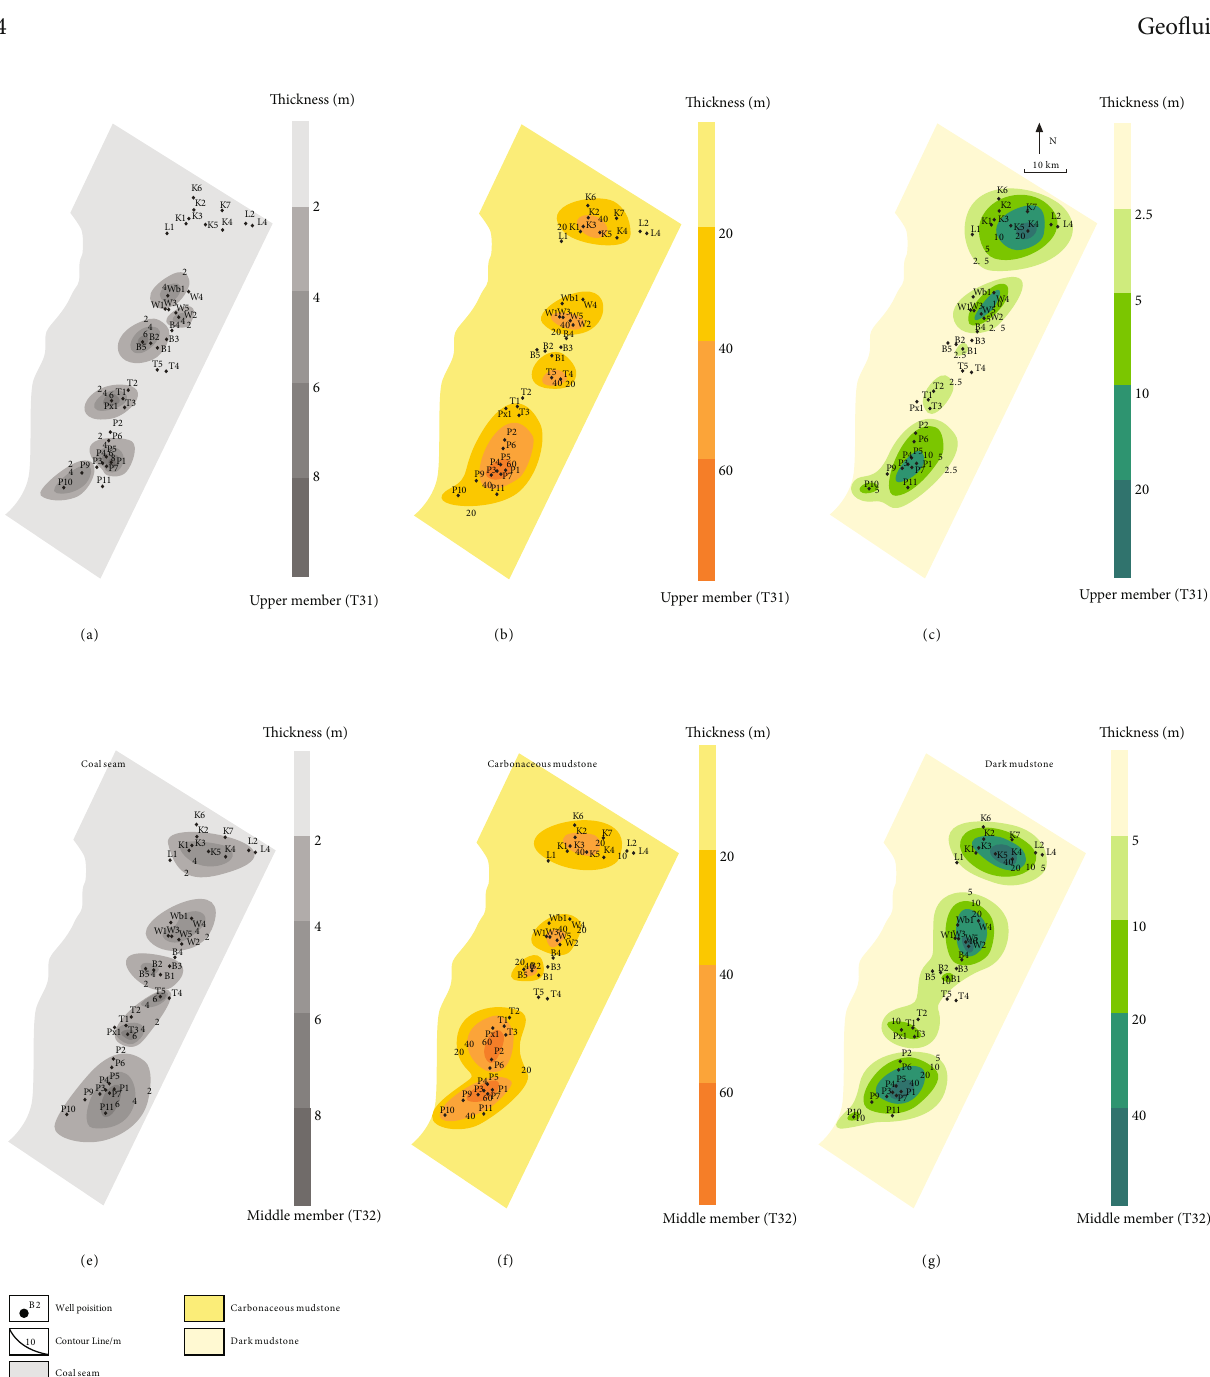
Figure 12: Development and distribution of coal-measure source rocks in the upper member (T31) and middle member